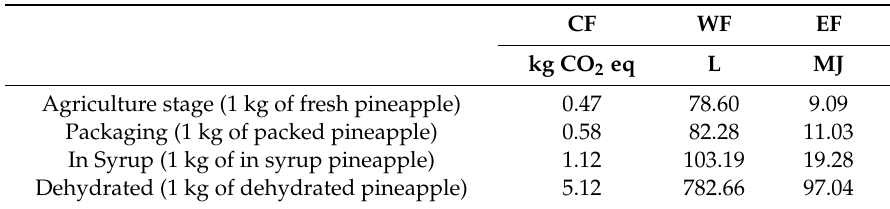
Table 6. Environmental impacts per impact